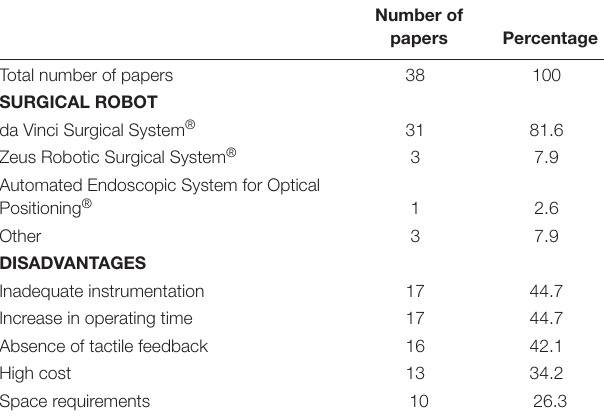
tabLe 1 | Limitations of surgical robotics.